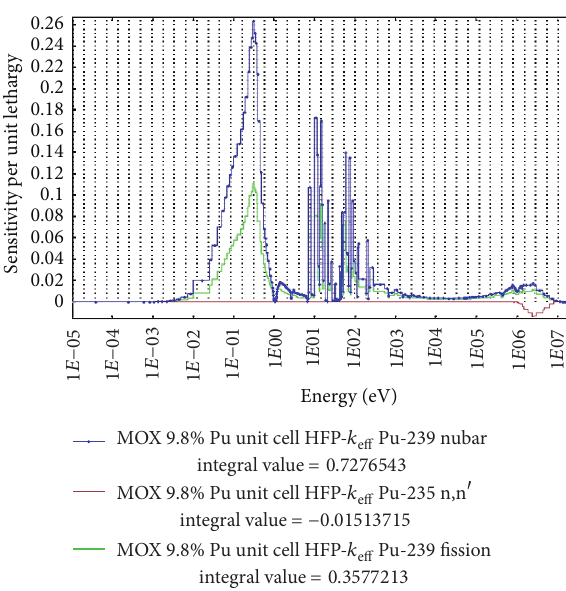
sensitivity profiles for the BWR PB-2 unit cell case eff 𝑘𝑘